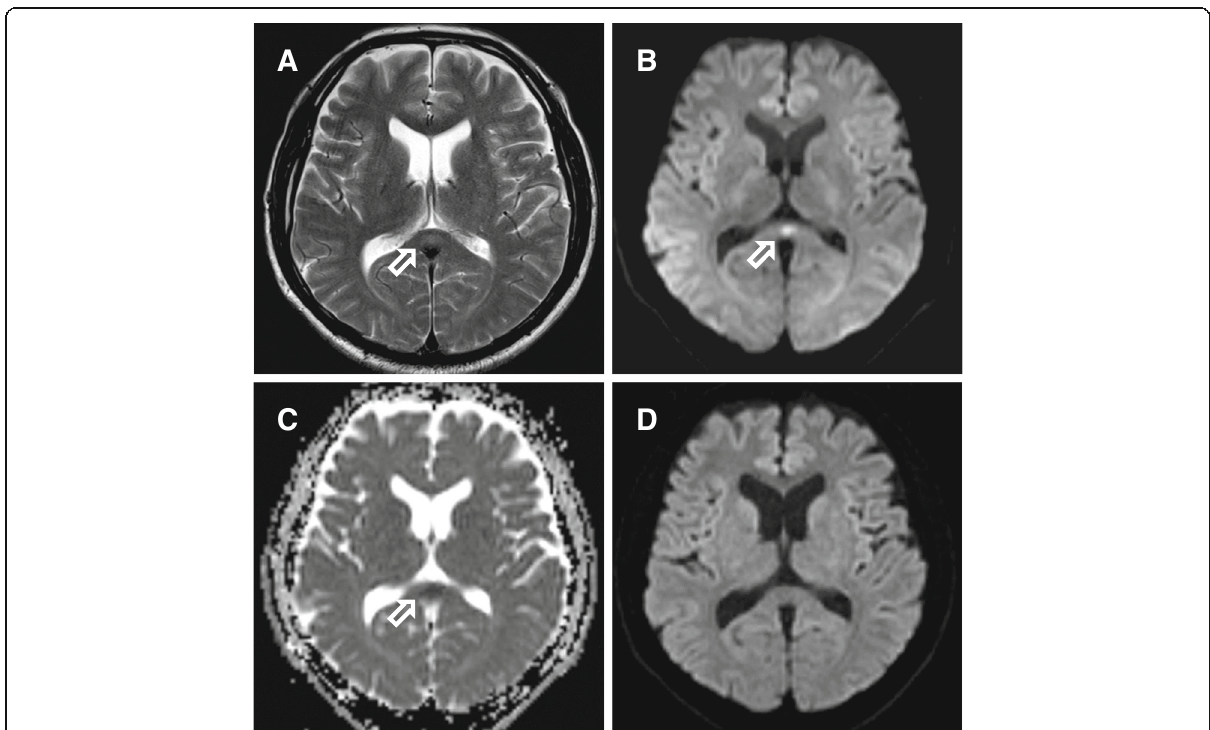
Fig. 2 a – c Brain magnetic resonance images on day 3 of illness. a The T2-weighted image and b the diffusion-weighted image show an oval- shaped high-signal lesion in the splenium of the corpus callosum (arrow). c The apparent diffusion coefficient is decreased. d Brain magnetic resonance diffusion-weighted image on day 16 shows complete resolution of the